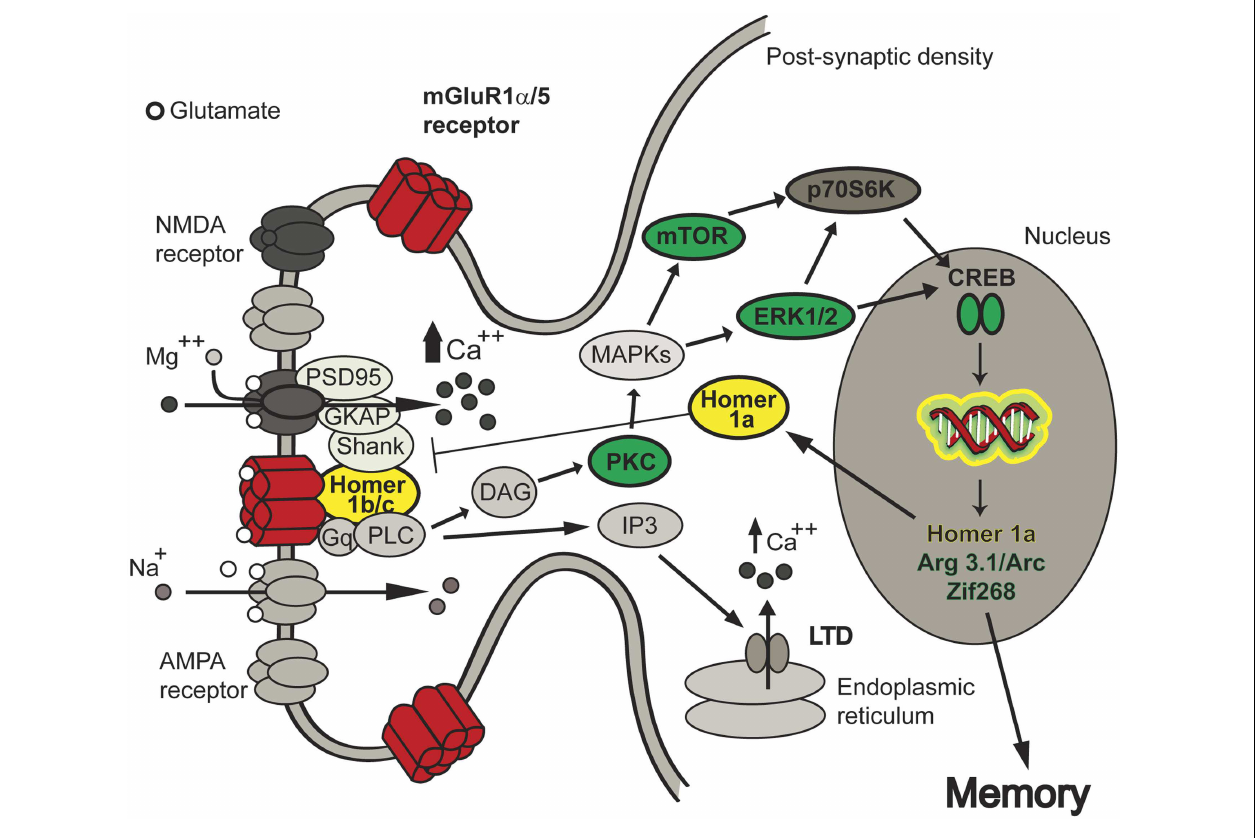
FIGURE 2 | Signaling pathways involved in mGluR-LTD and hippocampus-dependent spatial memory. Group 1 metabotropic glutamate receptors (mGluR1 α /5) are bound to ionotropic glutamate receptors by multiple scaffolding proteins (Homer 1 b/c, Shank, GKAP, PSD-95). Following mGluR stimulation, several protein kinases including PKC, ERK1/2, mTOR, and CREB become activated and induce